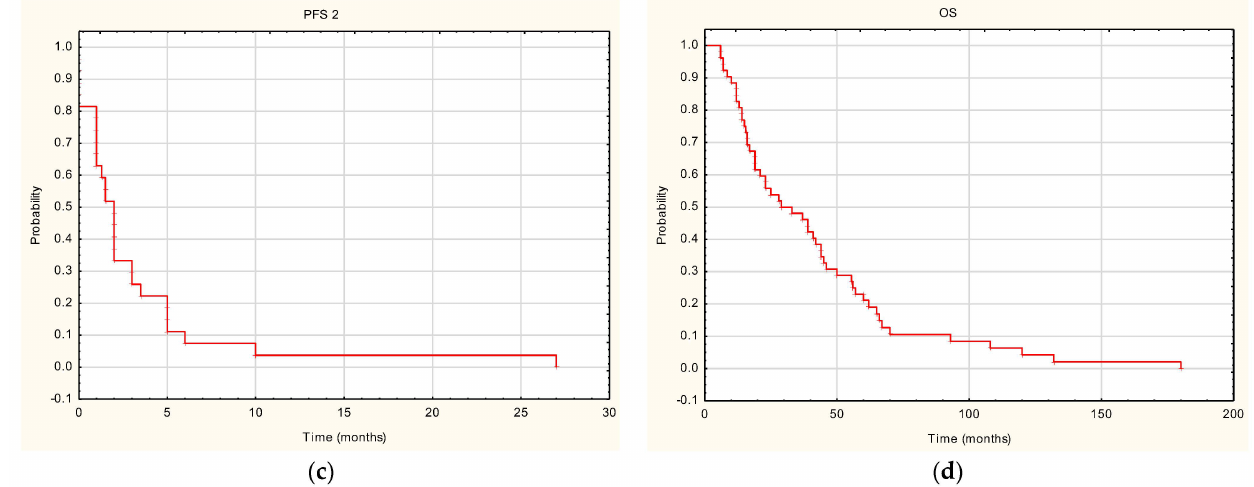
Figure 1. Survival outcomes: ( a ) time to relapse after surgery (RFS); ( b ) time to first progression after first-line treatment (PFS1); ( c ) time to second progression after second-line treatment (PFS2); ( d ) overall survival (OS).